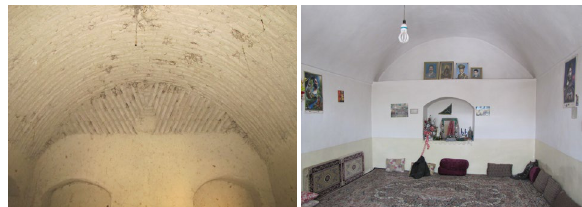
Figure 9. The Barrel vault executed in a residential space,